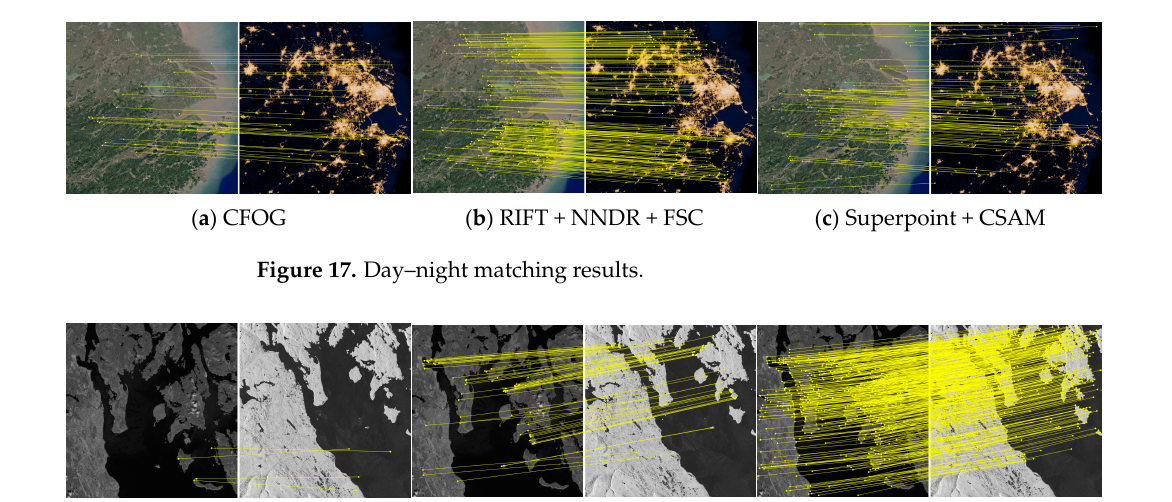
Figure 16. Optical–SAR matching results.